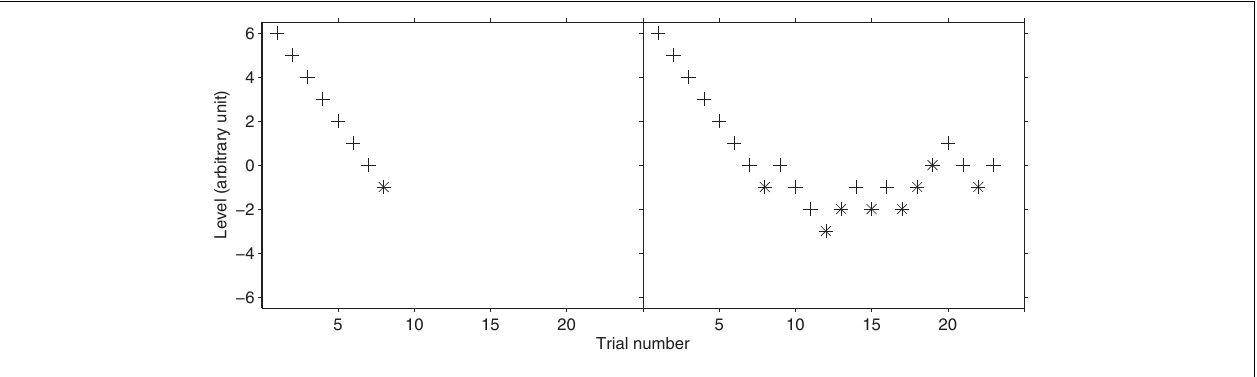
FIGURE 2 | Hypothetical threshold tracking with the method of limits (left) and with the simple up-down procedure (right). The plus sign represents the correct responses whereas asterisk